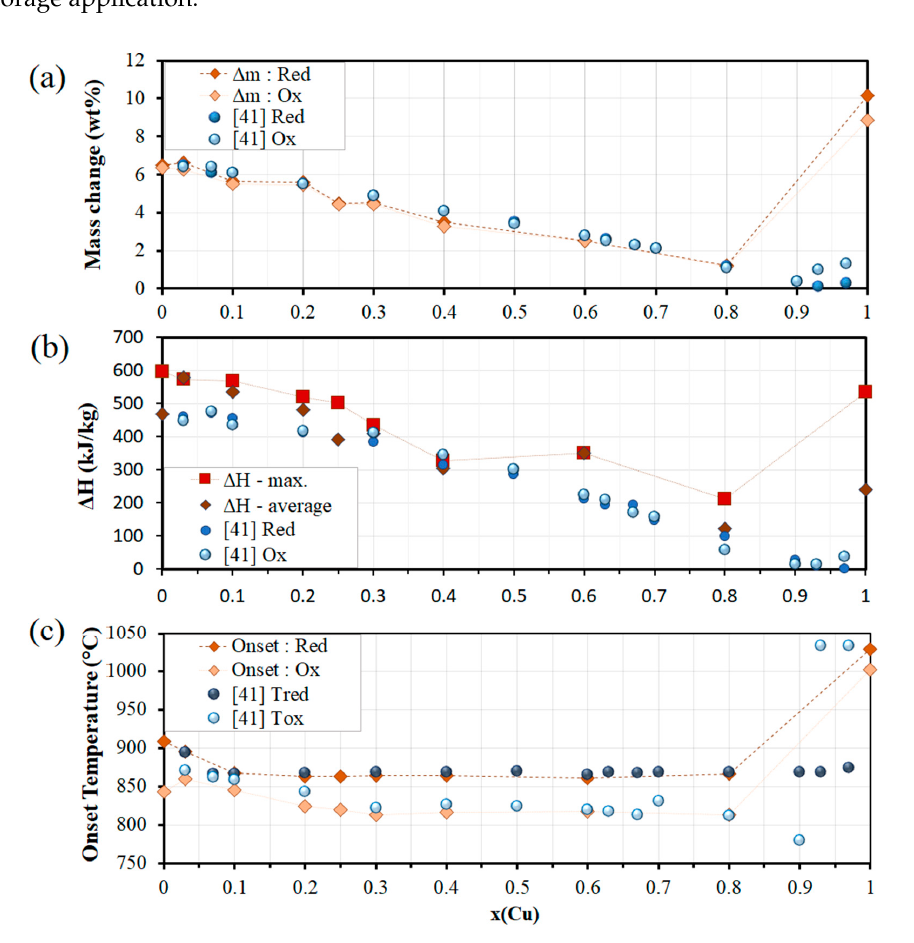
Figure 3. Mass variation (OSC), enthalpy change and onset temperatures of redox reactions measured for the Co-Cu-O system.